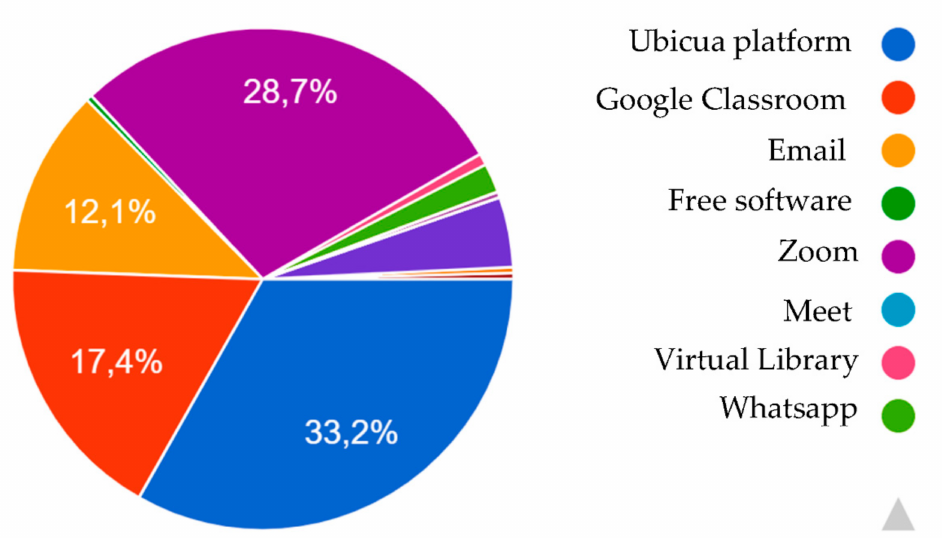
Figure 2. Technological tools in remote learning